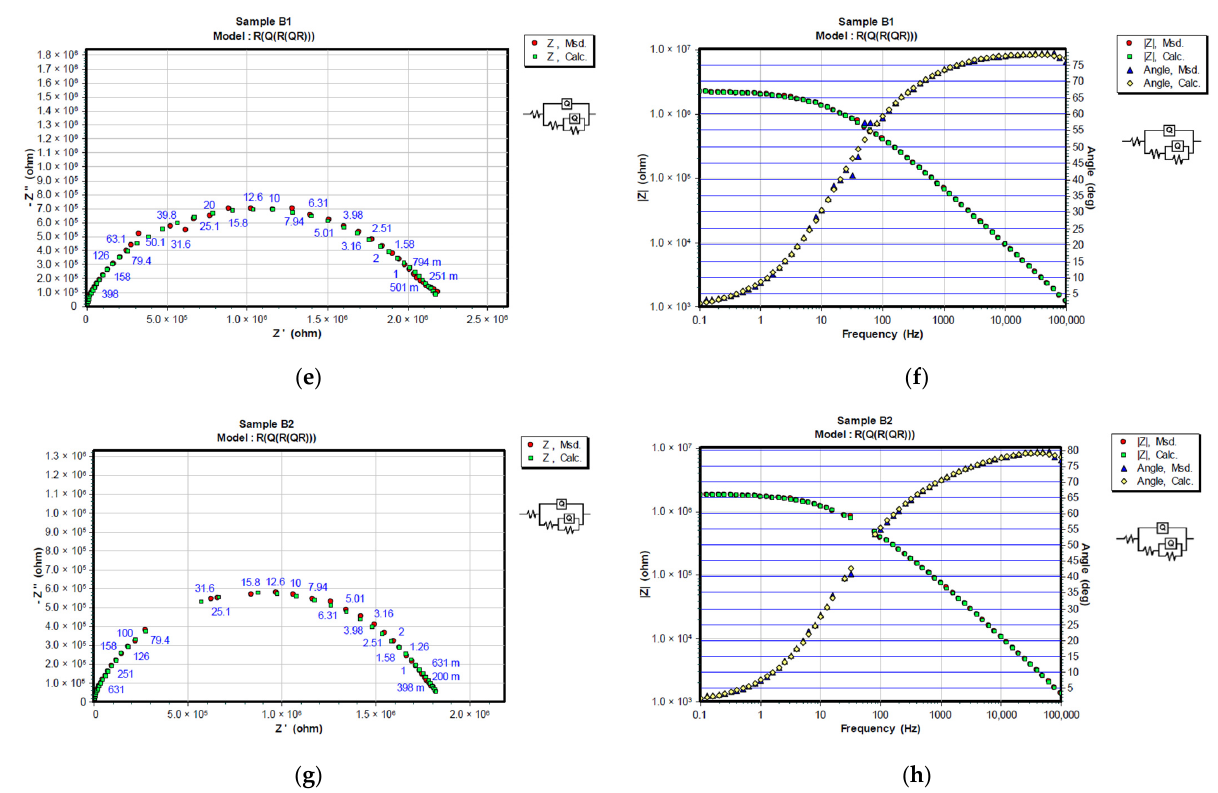
Figure 7. Representation of CNLS simulated and experimental data for each sample after 24 h in 3% NaCl solution with Nyquist and Bode plots. Nyquist diagrams are represented in ( a ) A1, ( c ) A2, ( e ) B1 and ( g ) B2, while Bode and Phase-angle plots are shown in ( b ) A1, ( d ) A2, ( f ) B1 and ( h ) B2. Table 7. Fitted values of equivalent circuit elements (R s , C C /Q c , R c , C dl /Q dl , R ct, W) and the corresponding chi-square value ( χ 2 ) after 24 h in 3% NaCl.